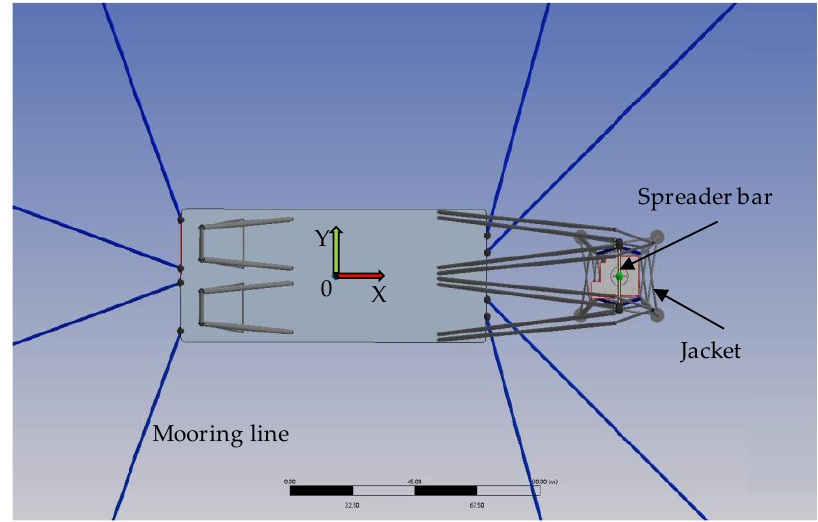
Figure 2. General sketch of the lowering system in an arbitrary location.